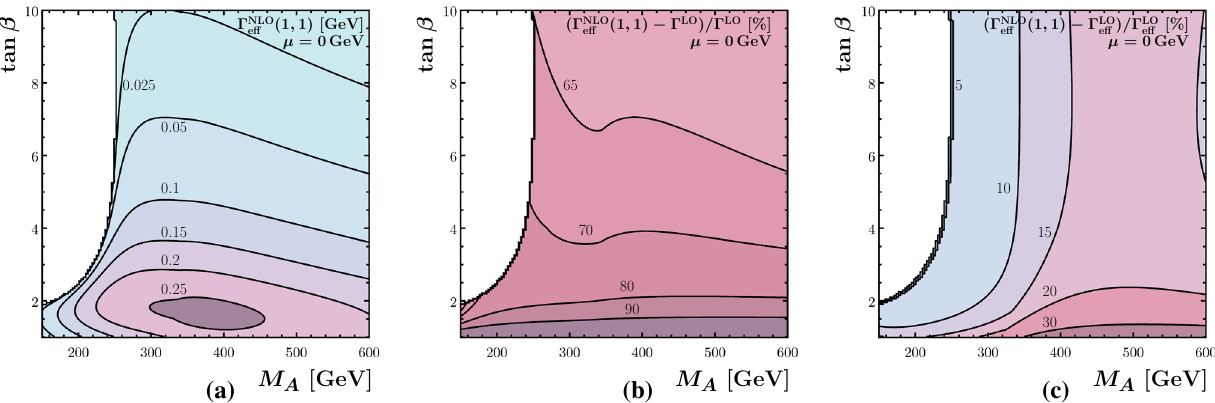
Fig. 5 a Partial decay width H → hh in GeV at NLO as a function of M A and tan β ; b Relative correction with respect to the pure tree-level result (cid:11) LO ; c Relative correction with respect to the tree-level result (cid:11) LO